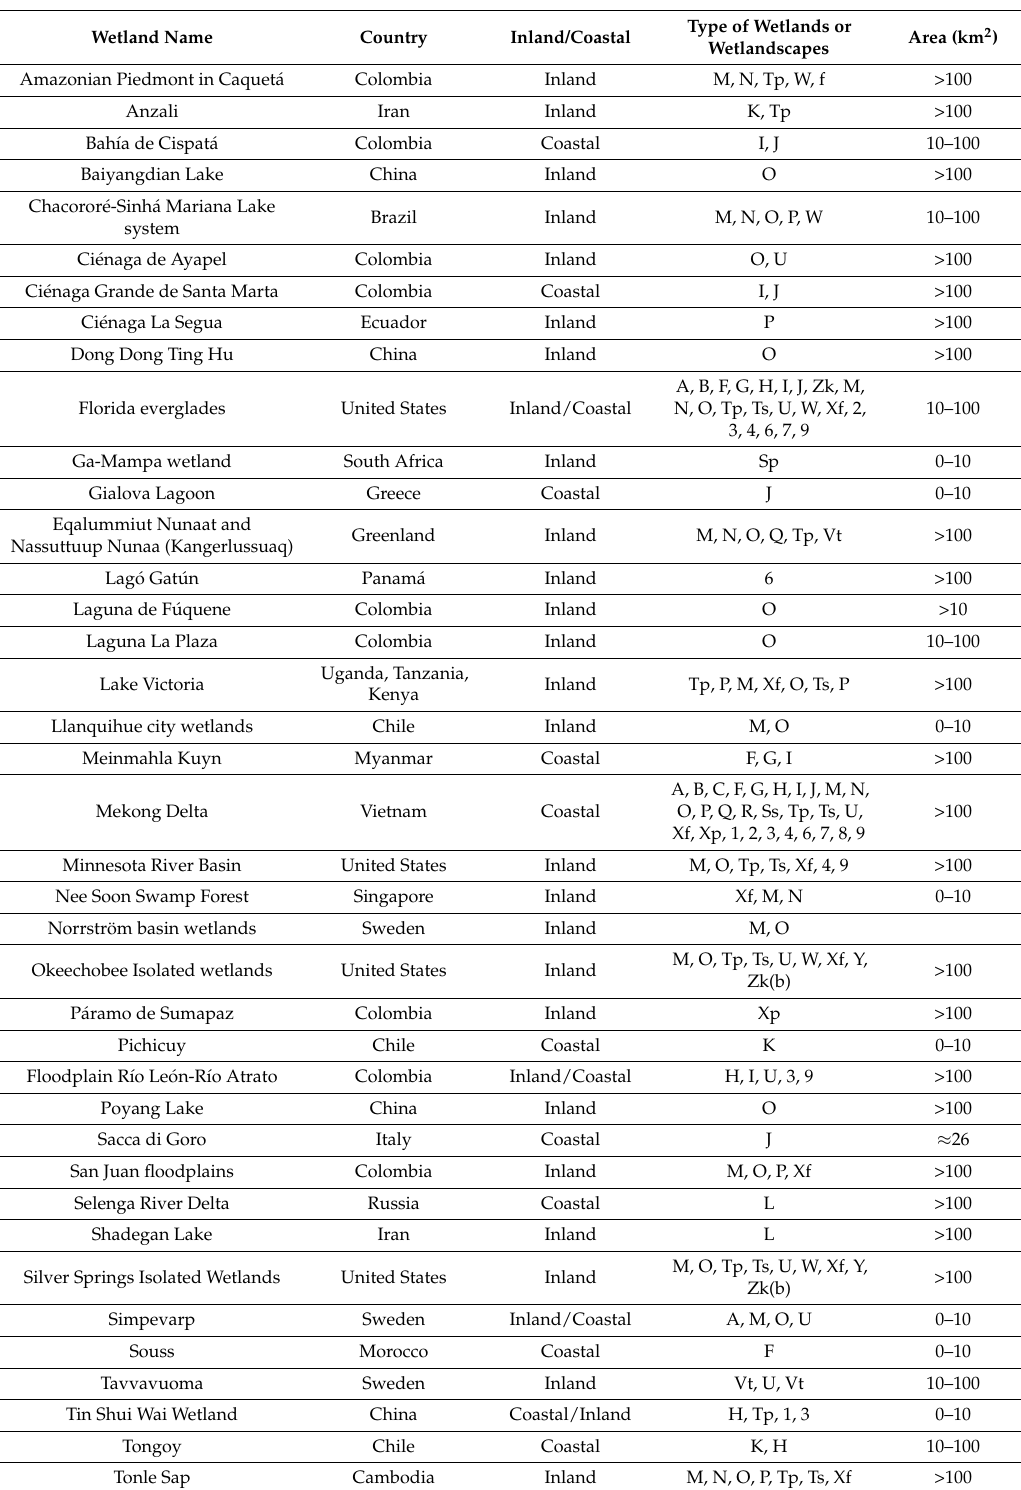
Table 1. Wetlands and wetlandscapes included in this study. The column of Type of Wetland is based on the definition of the classification* of the Ramsar convention; http://www.environment.gov.au/